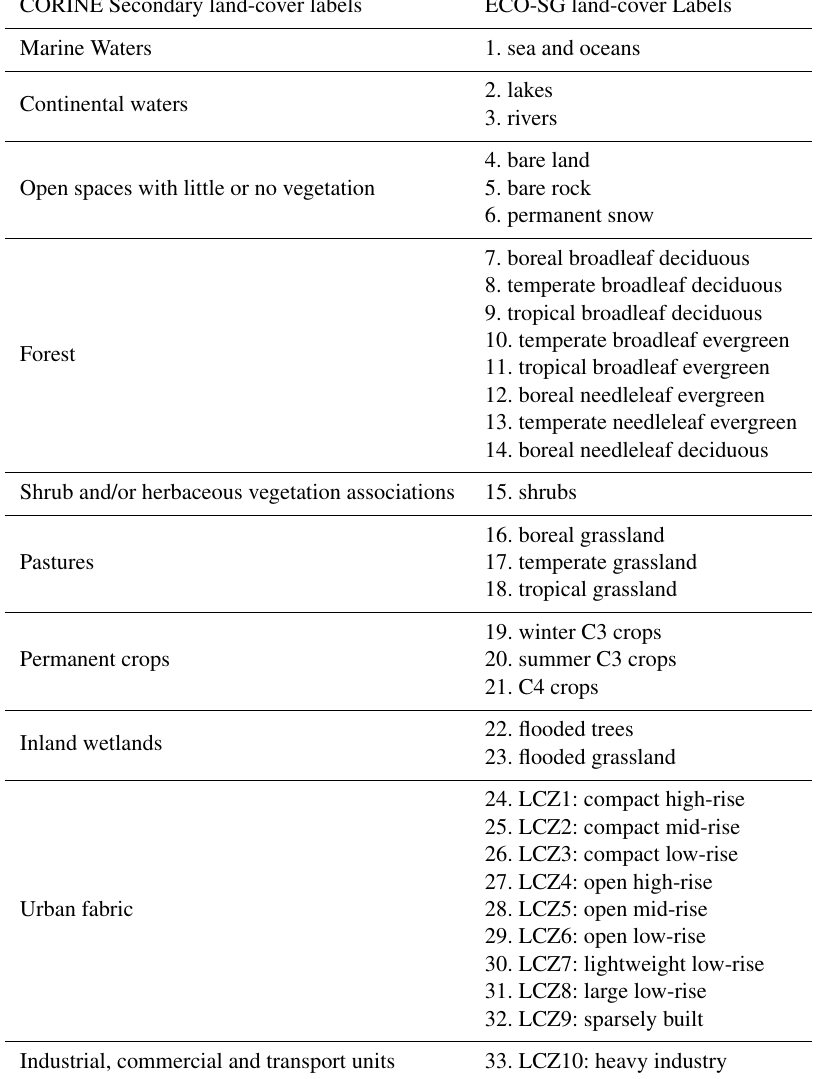
Table A2. Conversion table for ECO-SG labels to secondary CORINE